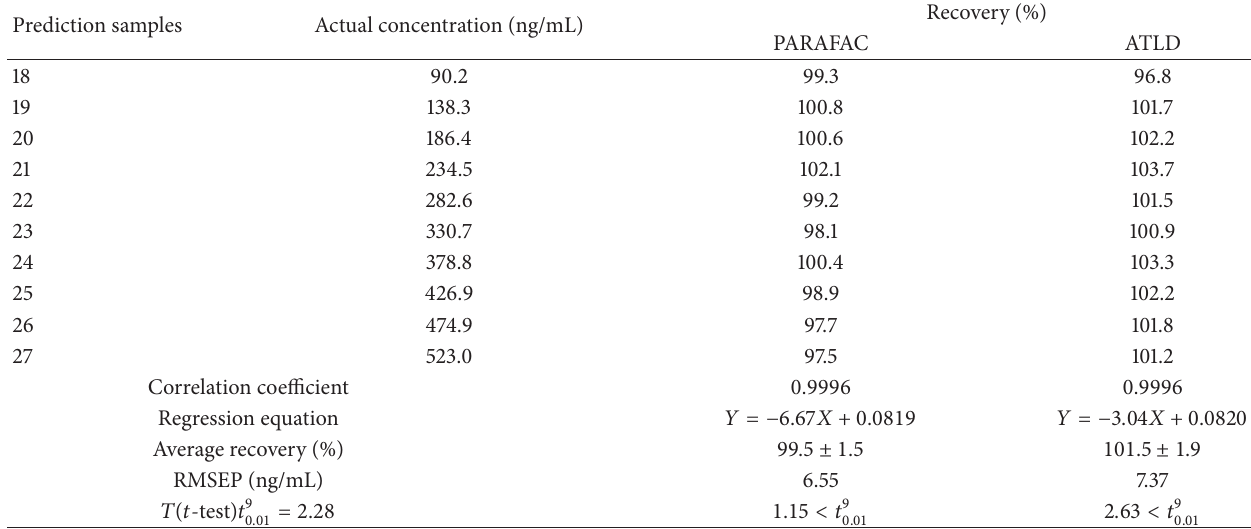
Table 3: Determination of valsartan in human plasma using PARAFAC and ATLD. Prediction